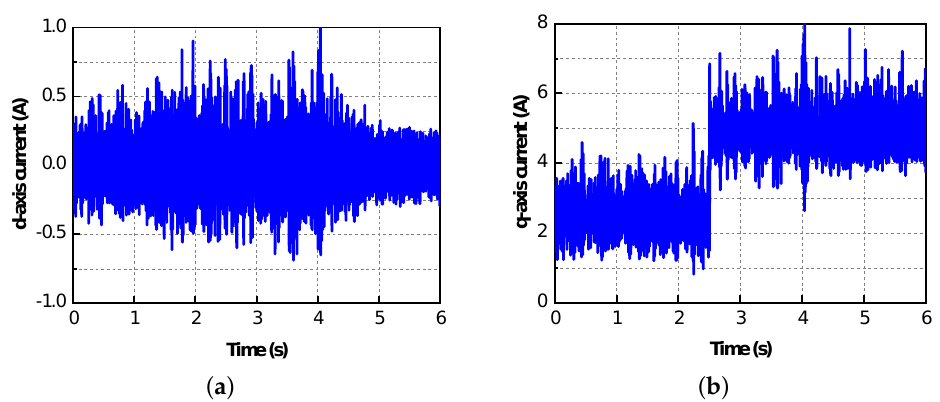
Figure 20. Simulation results without inductance estimation. ( a ) d-axis current and ( b ) q-axis current.